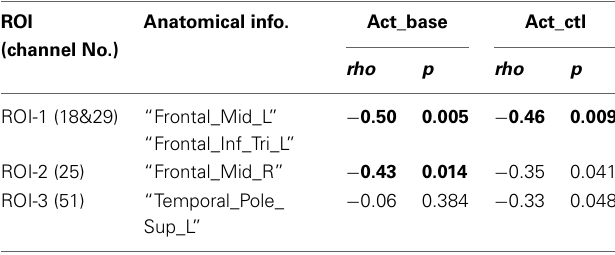
activation values in